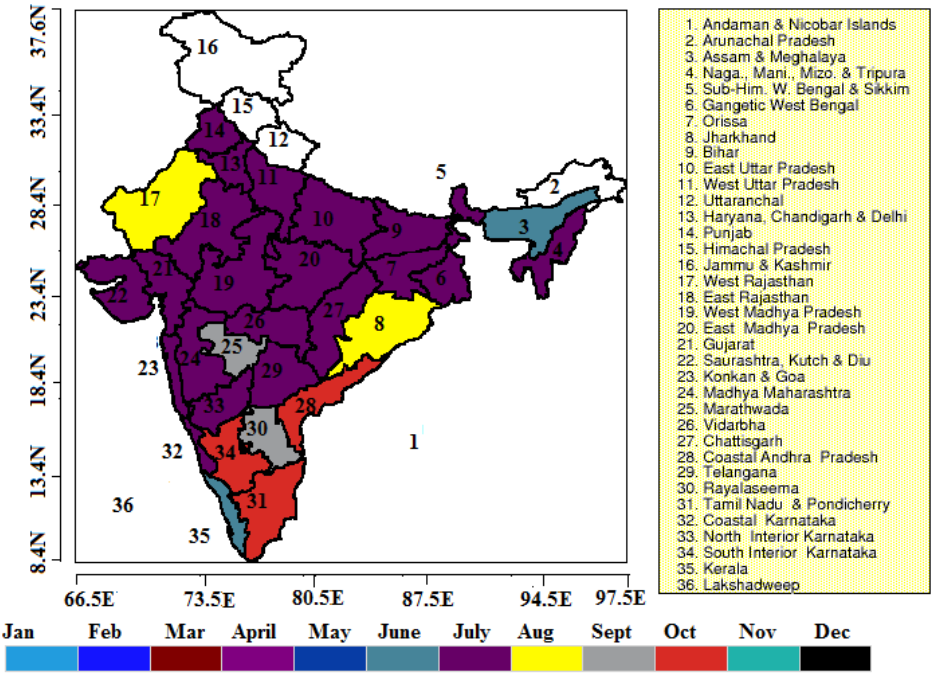
Figure 1. Observed MRPM across meteorological sub-divisions during 1871–2005.